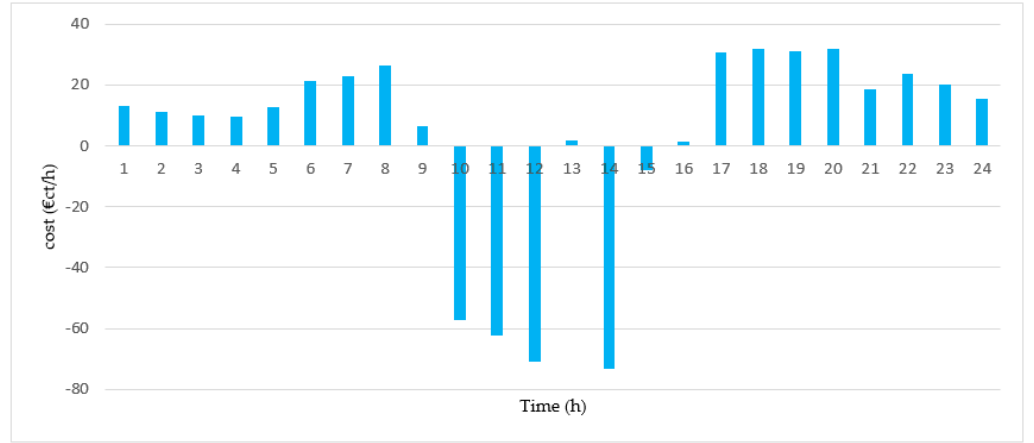
Figure 15. The optimal operation cost of the second scenario for each hour a day.